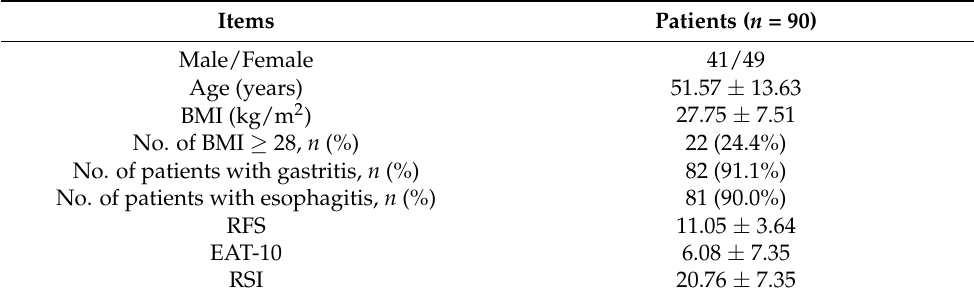
Table 1. Patient’s baseline characteristics.